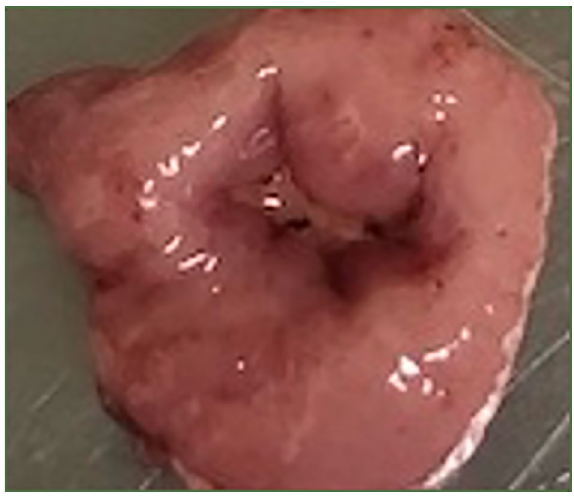
Figure 4. Thirty-six hours after ulcer induction. The ulcer was induced by acetic acid application at 60% v/v concentration for 60 s to an area 8 mm in diameter of the serosal side of the rat